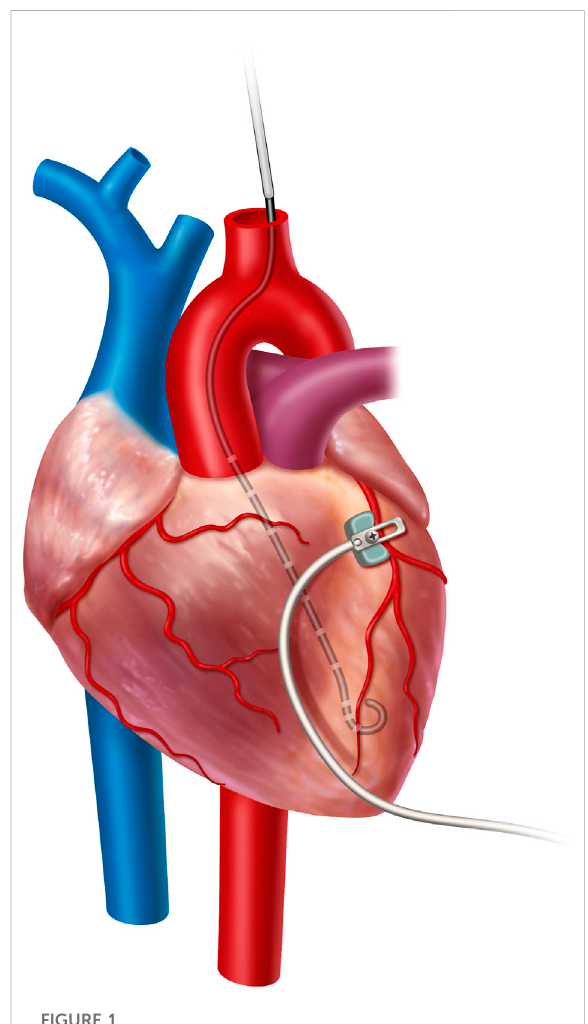
FIGURE 1 Cartoon representation of thecentral instrumentation, with a PV loop in the left ventricle and the dissected left coronary artery with LAD coronary fl ow probe placement. Not shown is a peripherally inserted,solid-statepressurecatheter forcentral venouspressuremonitoringand aperipherally inserted solid-state pressure catheter for arterial blood pressure